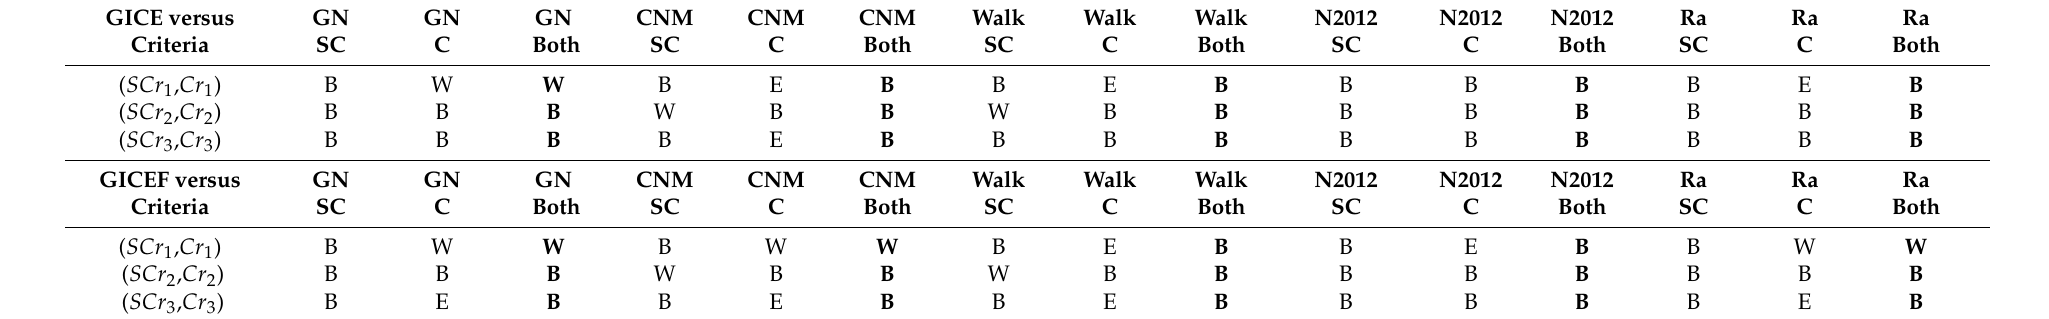
Table 7. Comparison between GICE and GICEF algorithms versus GN, CNM, Walktrap (Walk), N2012 and Radicchi (Ra) algorithms from a Modularity and Homogeneity point of view in the criteria Cr 1 , Cr 2 , Cr 3 and SCr 1 , SCr 2 , SCr 3 for the dolphins network. Letter B represent that our algorithm present better performance in this criteria, W worst and E represent that the difference is not